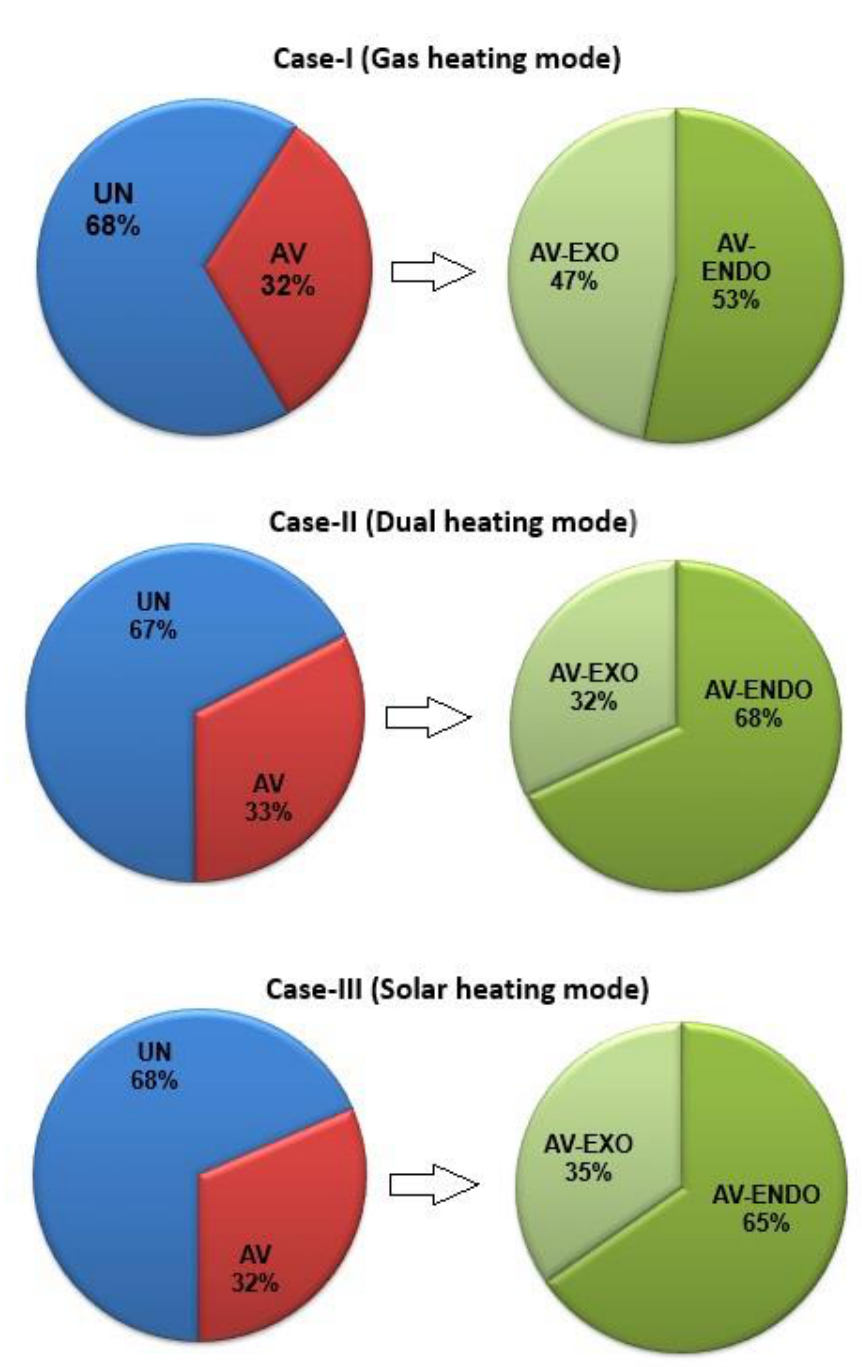
Figure 5. Percentage distribution of total exergy destruction into avoidable and unavoidable (left column) and division of avoidable exergy part into its endogenous and exogenous portions (right column) for the drying process of overall system under three different heating modes.